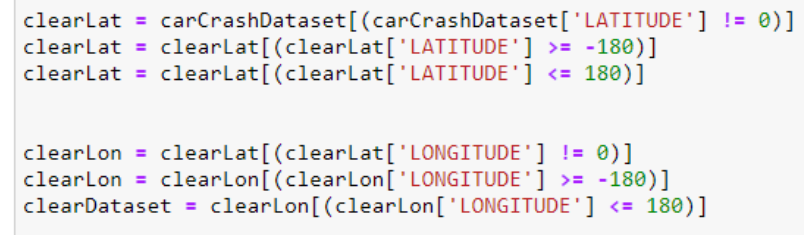
Figure 6. Cleaning the dataset of incorrect data.